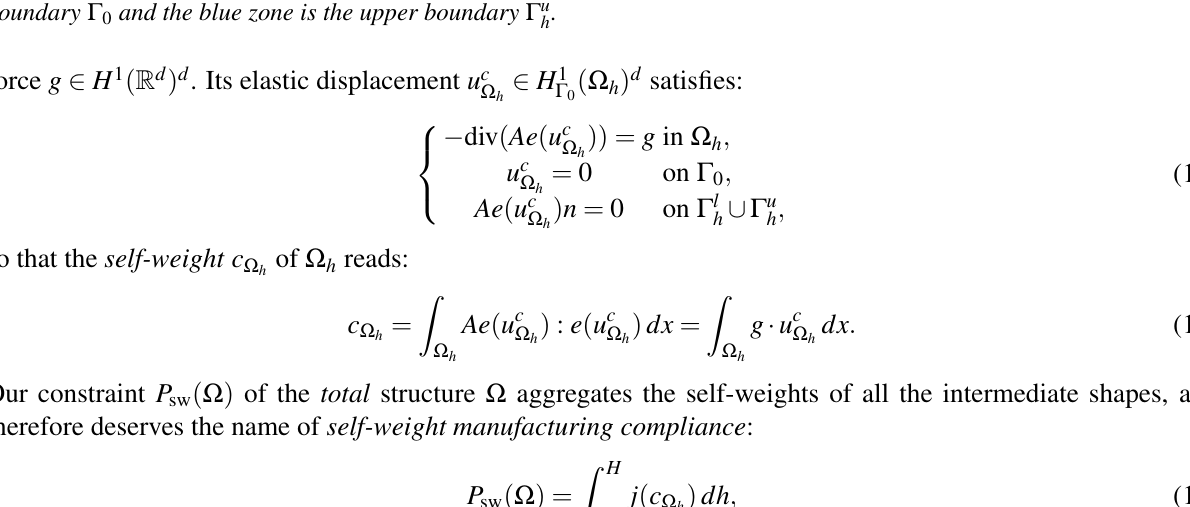
Fig. 5 Intermediate shape Ω h at height h during the construction of the final structure Ω : the red zone is the lower boundary Γ 0 and the blue zone is the upper boundary Γ u h